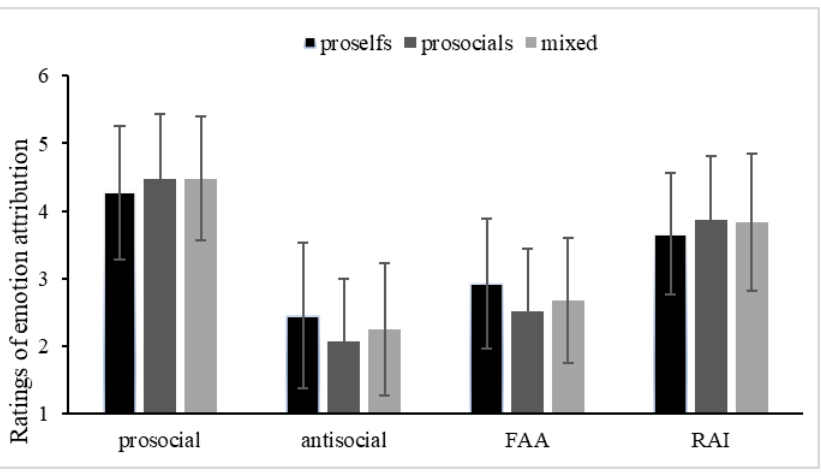
Figure 2. Ratings of Emotion Attribution in Different Contexts.